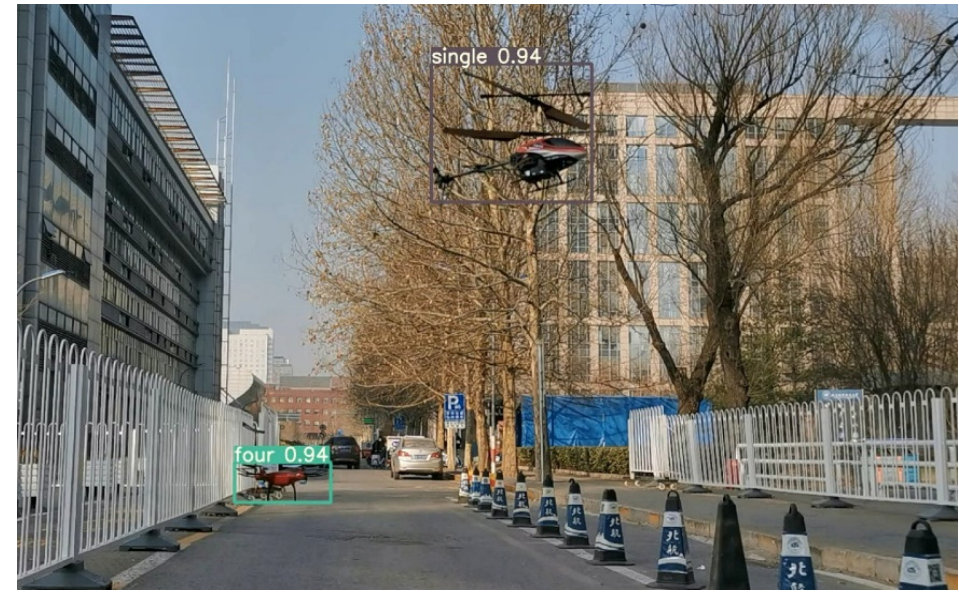
Figure 13. DPU detection effect diagram..